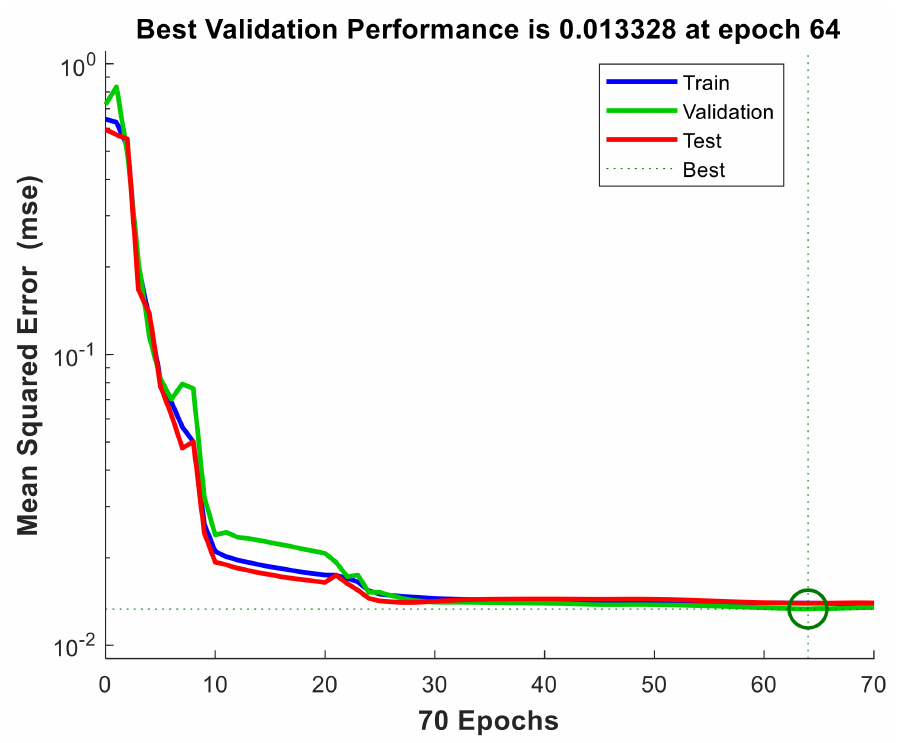
Figure 6. Number of epochs vs. mean square error for the gradual gas injection model.